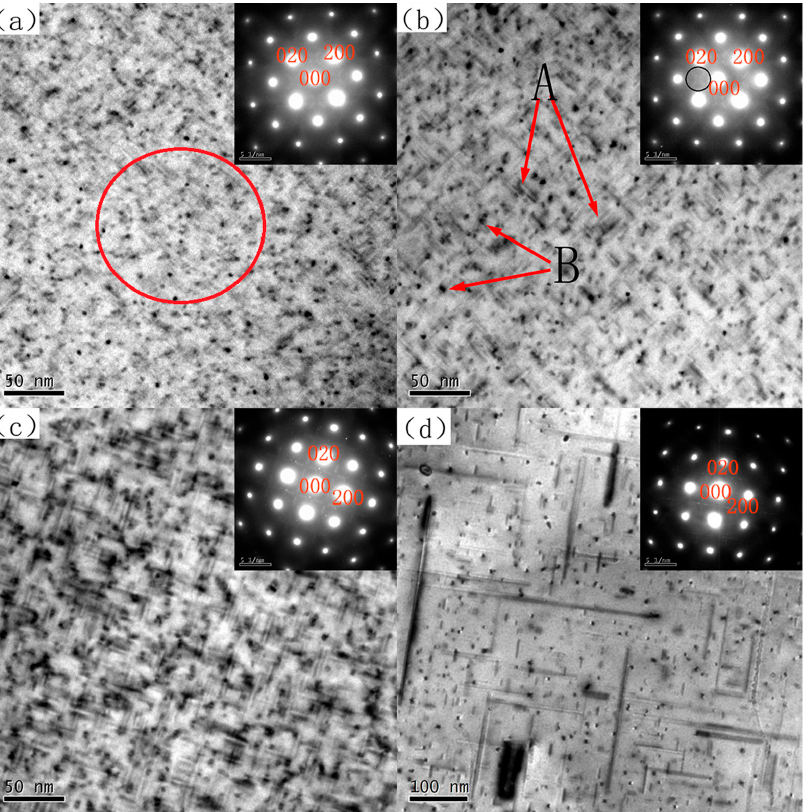
Figure 6. Images with the corresponding selected area diffraction patterns (SADPs)of AA specimens: ( a )4 h; ( b )8 h; ( c )24 h; ( d )96 h. ( a ) 4 h; ( b ) 8 h; ( c ) 24 h; ( d ) 96